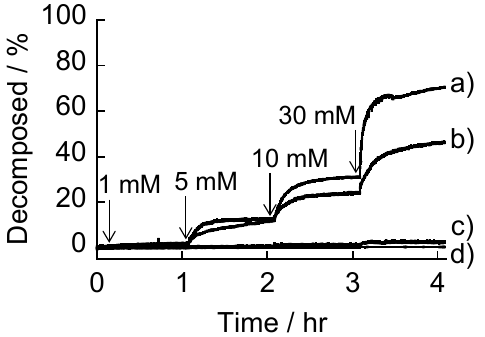
Figure 7. Decomposition of (AGA/19%PBA-PAMAM) 10 ( b , c ) and (AGA/39%PBA-PAMAM) 10 films ( a , d ) upon successive addition of fructose ( a , b ) and glucose ( c , d ) in buffer solutions at pH 7.5. LbL films were prepared at pH 7.5.